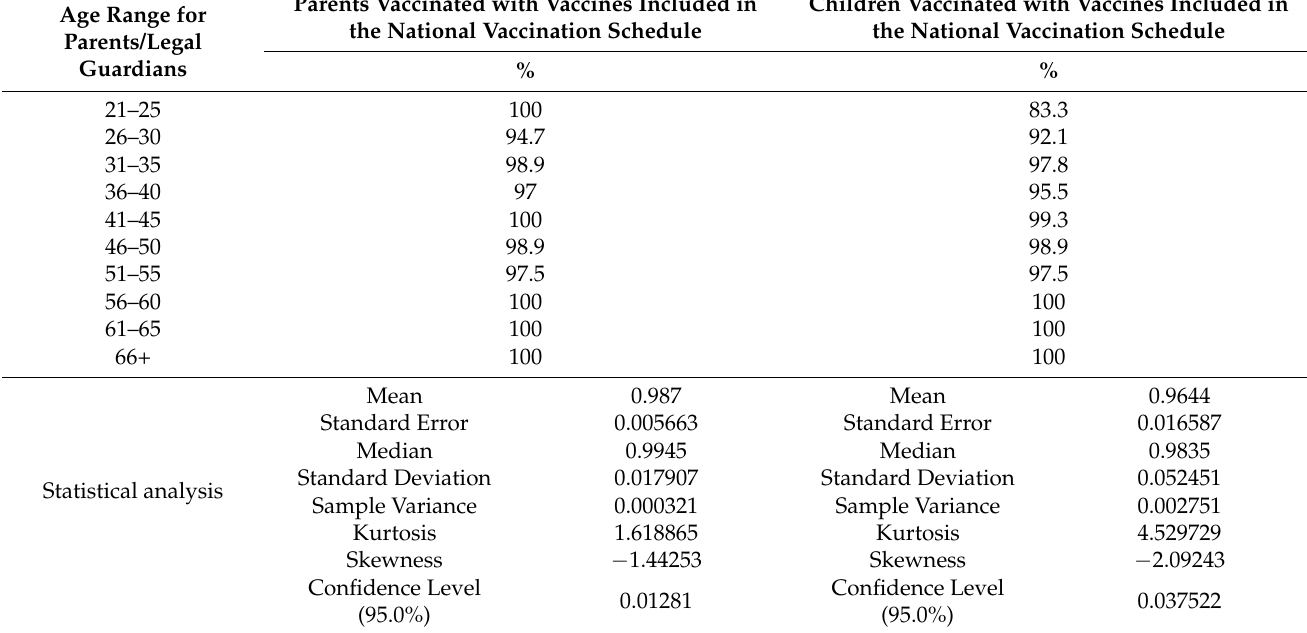
Table 5. Confidence in the mandatory vaccines included in the national scheme and in the optional vaccines ( like rotavirus vaccine, anti hepatitis A and B, meningococcal vaccine, etc.